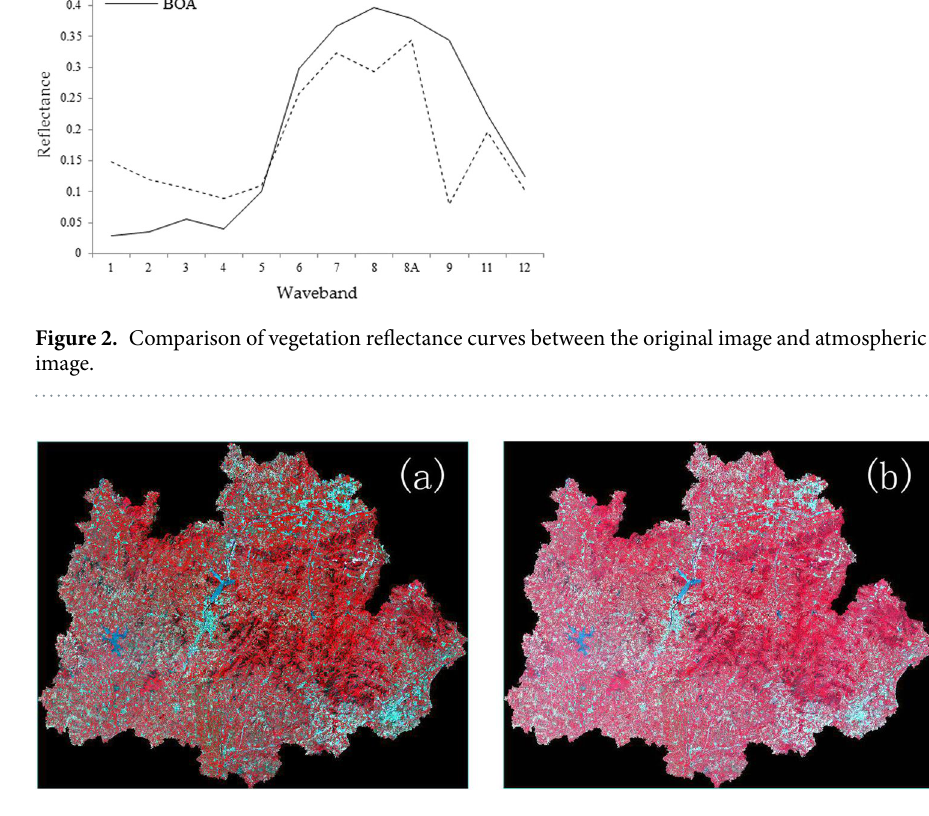
Figure 3. Image ( a ) is the image before Minnaert correction and image ( b ) is the image corrected by the Minnaert